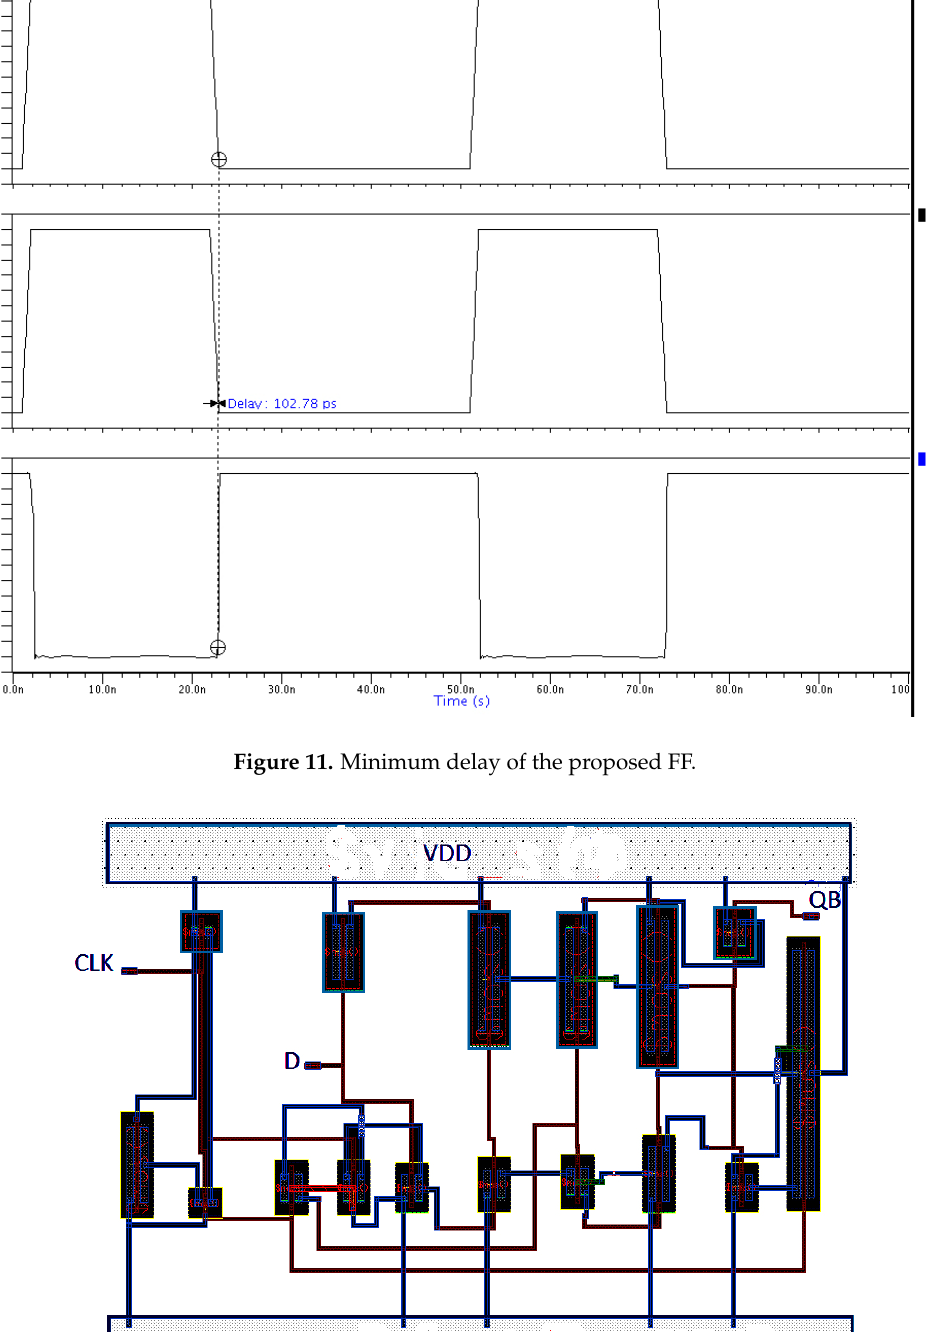
Figure 12. Layout of the proposed flip ‐ flop.